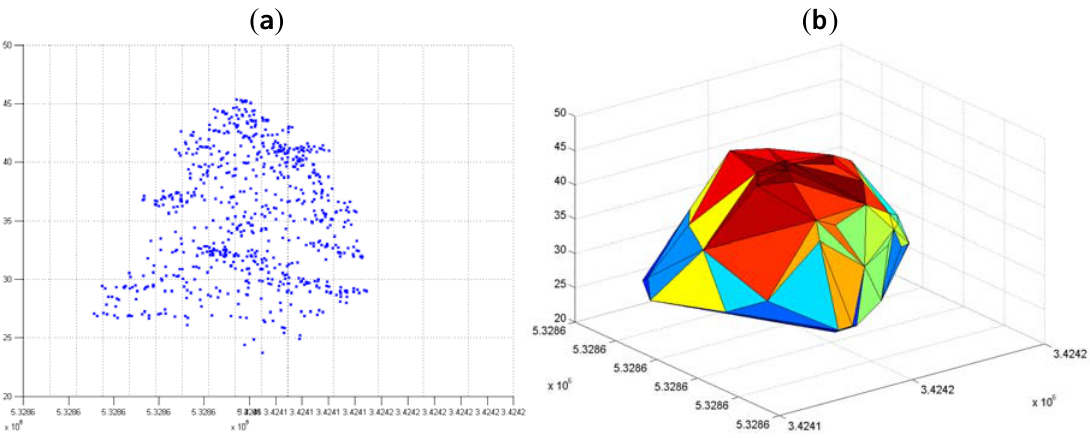
Figure 13. Cluster of an individual tree from Cell 6 after running M k -means without scaling down the height value on the dataset above 16 m height and respective convex polytope. ( a ) Cell 6—an individual tree cluster above 16 m height. ( b ) 3-D Convex polytope reconstructed from tree cluster as shown in ( a ). The x and y coordinate values (in meters) are displayed horizontally and the z value (in meters) is displayed